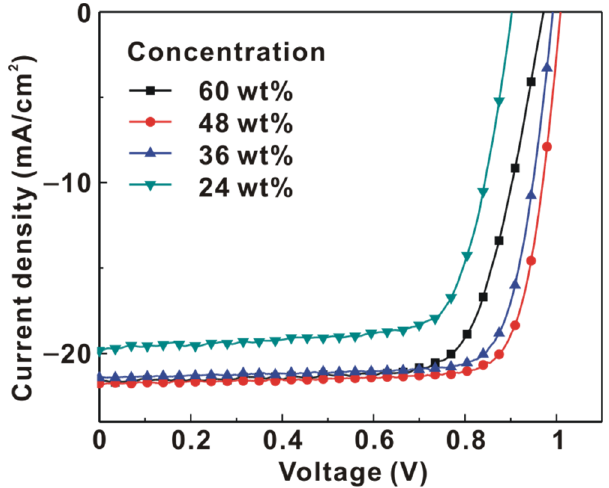
Figure 2. The current density–voltage curves of the P3CT-Na HTL-based MAPbI 3 solar cells under one sun illumination (100 mW/cm 2 , AM 1.5G). The concentration of the P3CT-Na precursor solution was varied from 60 wt% to 24 wt%. Table 1. The device performance statistics of the P3CT-Na HTL-based MAPbI 3 solar cells under one sun illumination (100 mW/cm 2 , AM 1.5G). The data were calculated using eight cells for each statistic. P3CT-Na/Water